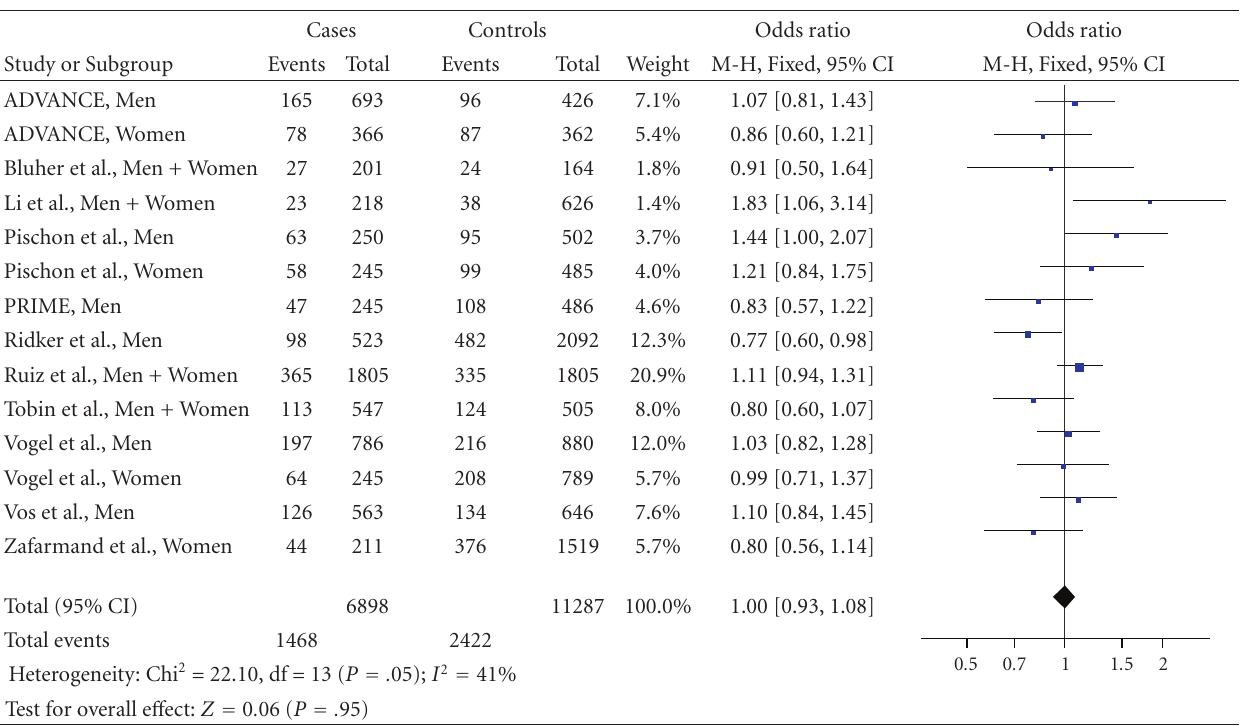
(b) Meta-analysis of CHD risk for the PPARG Pro12Ala polymorphism under the recessive model. Cases